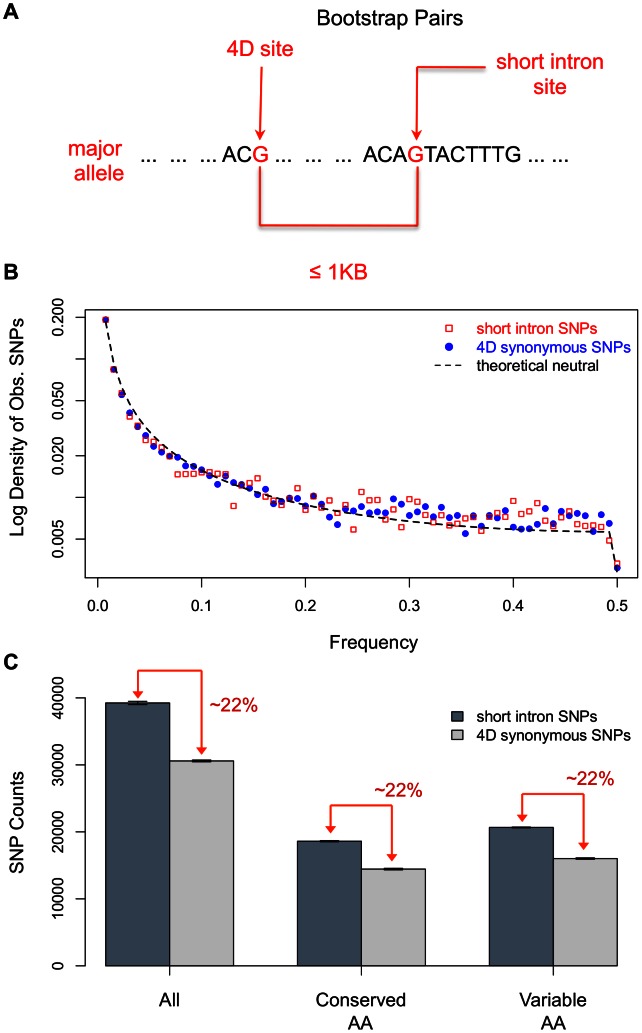
The signal of strong selection acting on 4D sites.(A) Overview of the bootstrap method. We sample 4D sites and their nearby (<1 KB apart) short intron pairs with replacement in order to control for linked selection and variation in GC content and mutation/recombination rates between the neutral reference (short introns) and the test set (4D sites). The short intron, 4D pair must have the same nucleotide as their major allele. (B) The folded Site Frequency Spectra (SFS) of observed SNPs from short introns, 4D sites, and the theoretical neutral distribution in a population with constant size. The SNPs were resampled to 130 strains and folded using the minor allele frequency. (C) The ratio of the amount of polymorphism in short introns versus 4D sites in all, conserved, and variable amino acids with standard error bars. Conserved amino acids are those present and identical in the 12 sequenced Drosophila genomes. Variable amino acids are defined as being not conserved according to the above definition. Ten bootstraps were done for each category (all, conserved, and variable) of 4D site. Lifting the restriction on distance and only controlling for GC content in the bootstrap produces identical results as above (not shown). To be conservative, we continued to use the distance restriction in the bootstrap. Note, had we simply taken the density of polymorphism as is without correction of GC content, we would've only seen a 7% drop in the density of polymorphism from short introns to 4D sites (5.58% vs 6.0% segregating in 4D versus short intron sites).